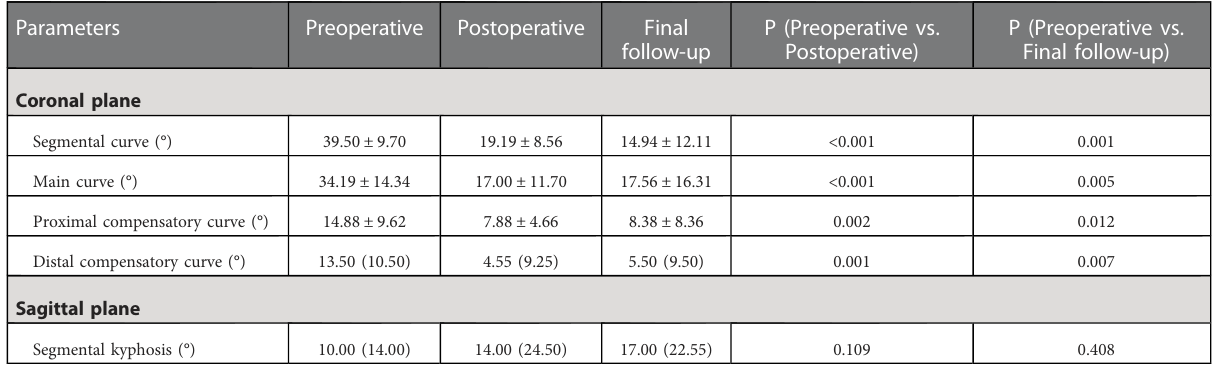
TABLE 2 Preoperative, postoperative, and last follow-up radiographic imaging parameters of children with congenital scoliosis who underwent posterior hemivertebral resection without internal fi xation. Parameters